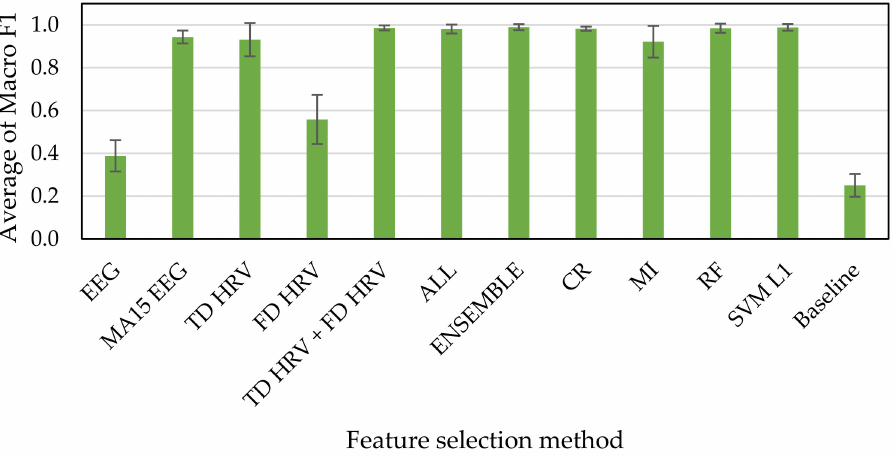
Figure 10. HAHV, HALV, LALV, LAHV (4 classes) emotion classification